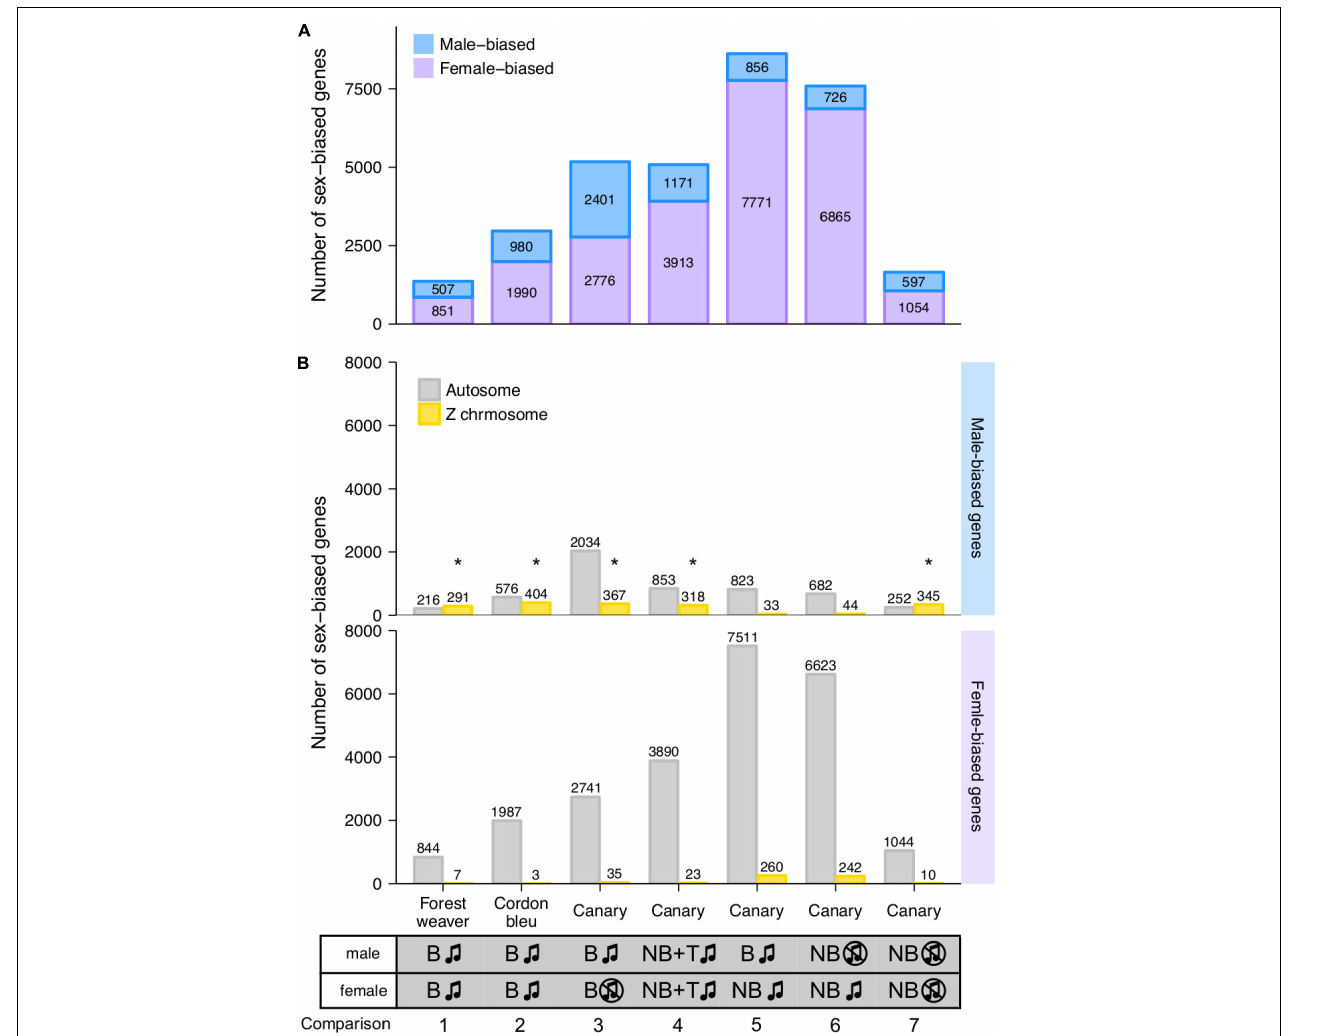
FIGURE 2 | Female- and male-biased sex differences in HVC gene expression levels in songbirds. (A) The bar graph summarises the number of sex-biased genes in the HVC transcriptome identified from each male-to-female comparisons. The phenotypes of the groups being compared in each male-to-female comparison are listed at the bottom of the graph. (B) The bar graph summarises the number of autosomal and Z chromosomal genes classified as male- and female-biased genes in the HVC transcriptome based on each male-to-female comparison. B, breeding; NB, non-breeding; T, testosterone implantation. The music note indicates the presence or absence of singing behaviour; the asterisk (*) indicates enrichment for Z chromosomal genes (adjusted p < 0.05, Fisher’s exact test followed by the Bonferroni correction for multiple testing, see Supplementary Table 1